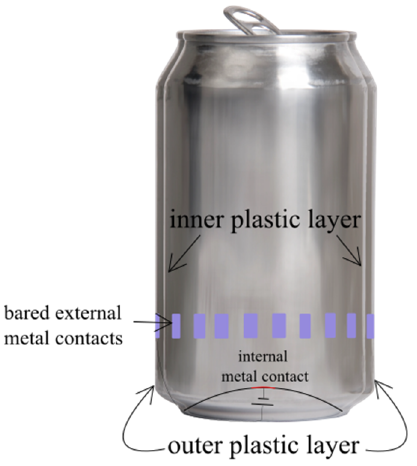
Figure 6. Structure for salt-based taste altering soda.